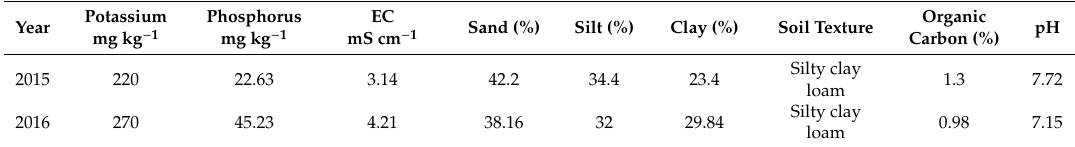
Table 2. Some physical and chemical characteristics of the field soil of the experimental site in 2015 and